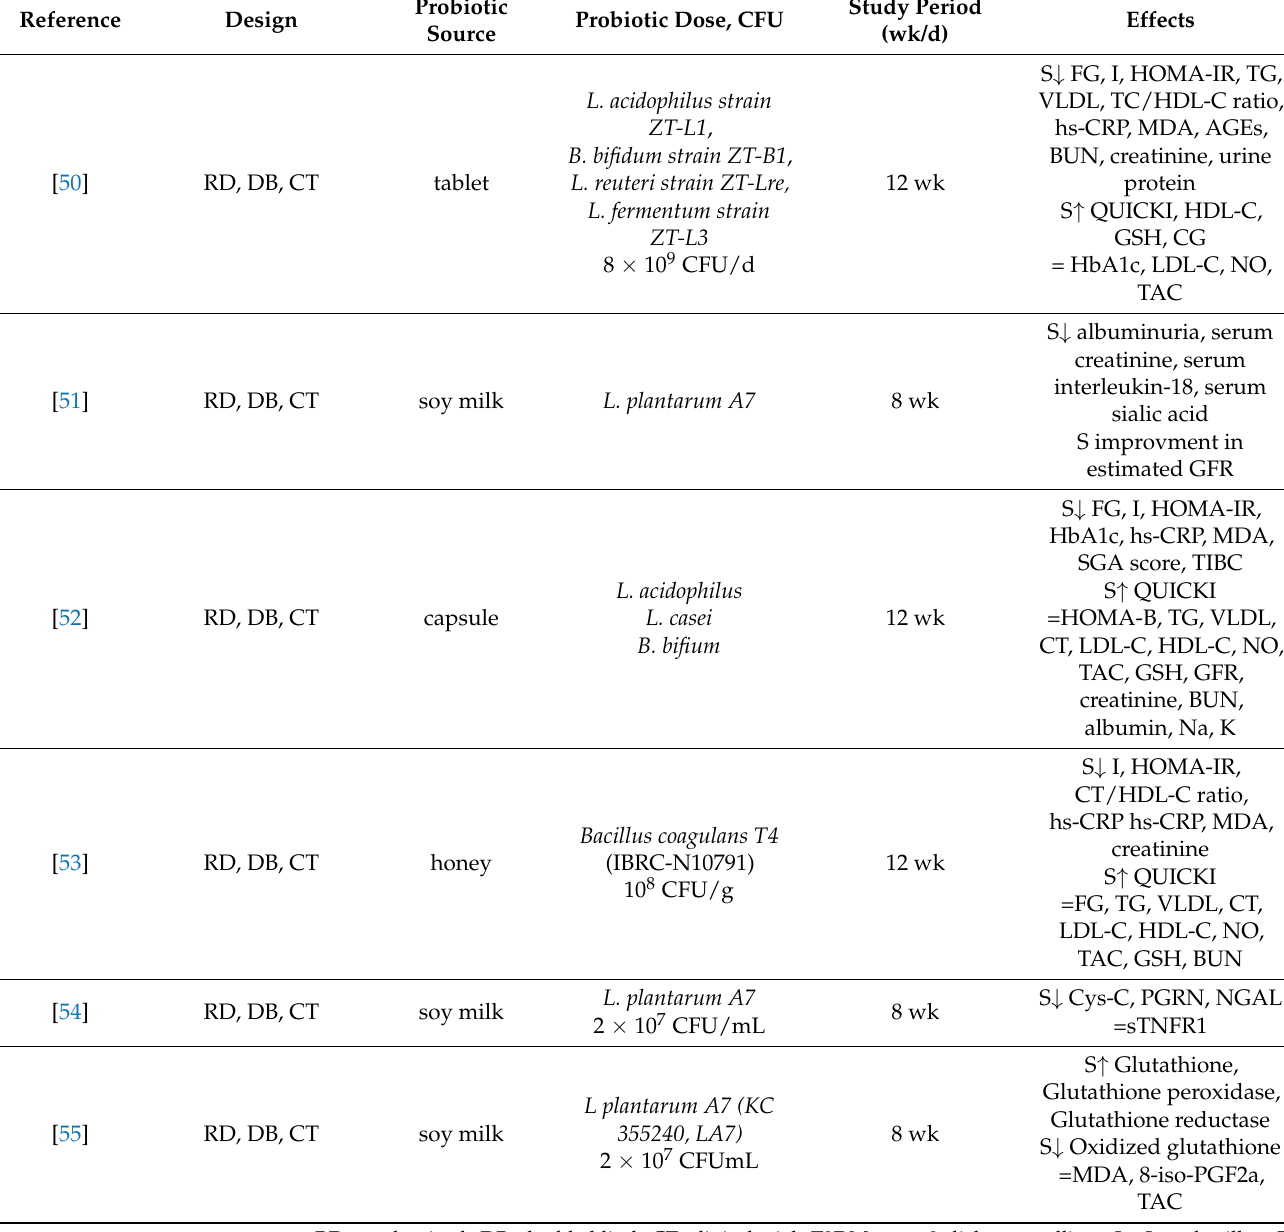
Table 1. Effects of probiotics on type 2 diabetes and kidney